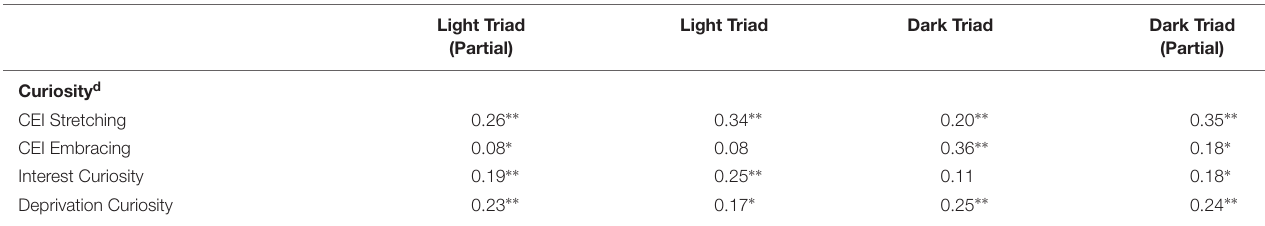
TABLE 16 | Correlations among curiosity and light triad, dark triad, and light vs. dark triad.